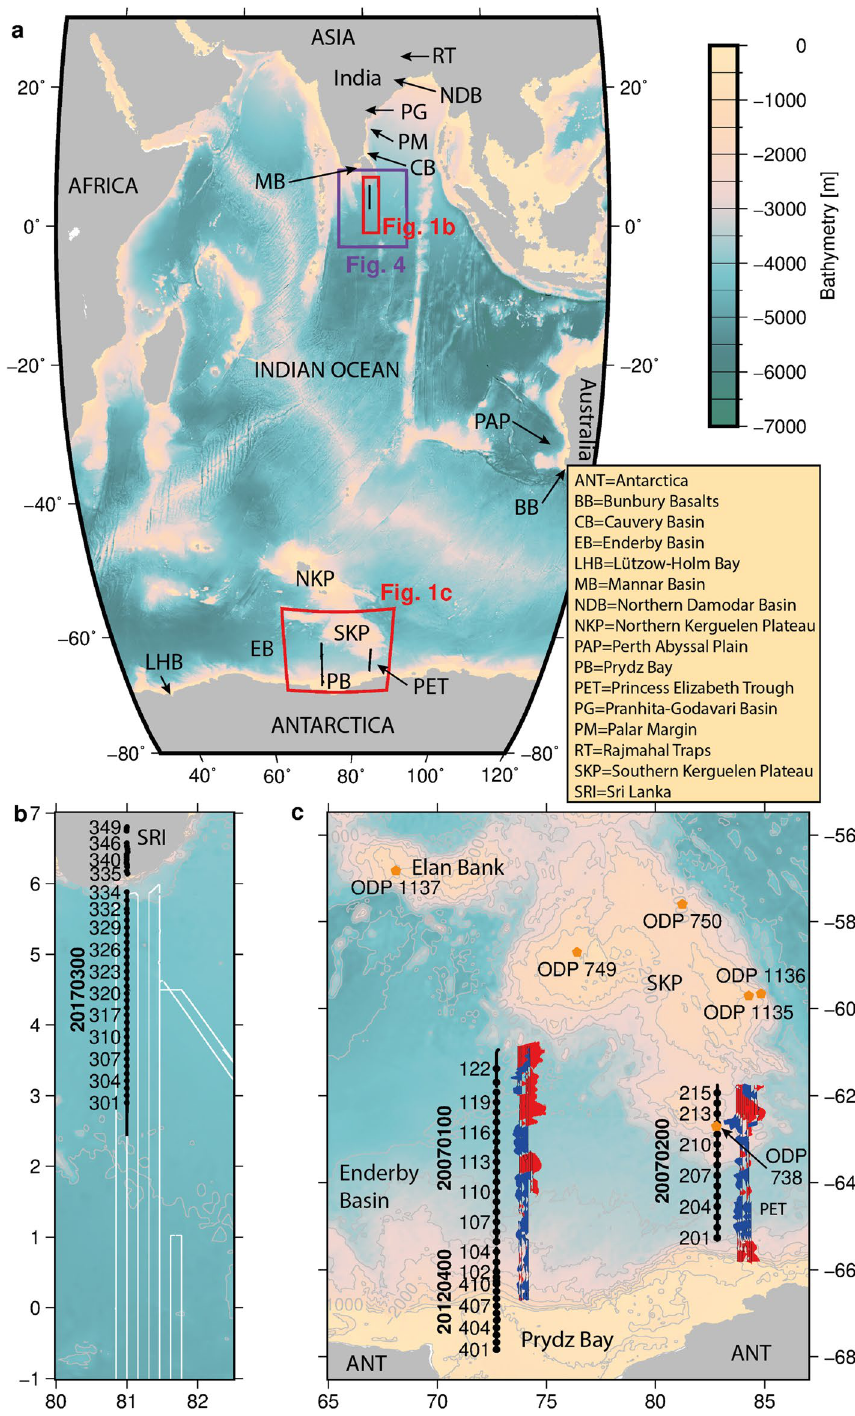
Figure 1. Location of magnetic and seismic profiles in the research areas. Maps: Generic Mapping Tools 36 . ( a ) Overview map showing the location of the research areas in this conjugate margin study. The red and purple boxes indicate the locations of newly-gathered magnetic and seismic data. Black lines mark the locations of newly-acquired seismic refraction data. ( b ) Location of deep seismic line 20170300. Black circles show the positions of the seismic stations on the seafloor and onshore Sri Lanka. White lines show the locations of newly acquired magnetic profiles. ( c ) Locations of the deep seismic profiles in the Enderby Basin and Princess Elizabeth Trough. Black circles represent the locations of OBS and OBH stations. ODP drill sites are marked in orange. Helicopter borne magnetic data (blue and red) were acquired in corridors centred on and parallel to the deep seismic lines. For clarity, they are shown here shifted